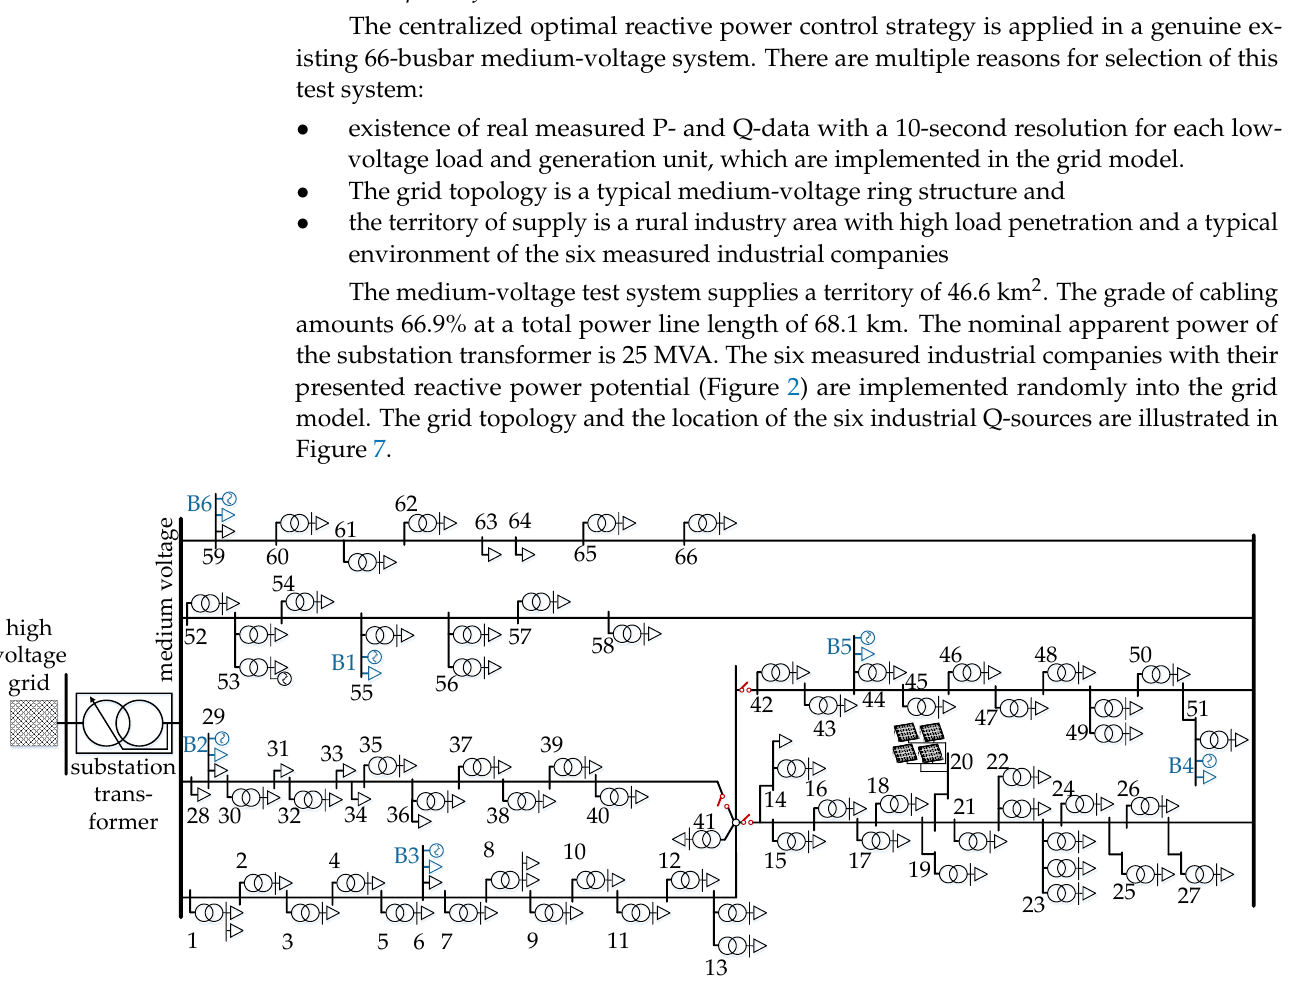
Figure 7. Schematic illustration of the radial topology of the regarded 66-busbar medium-voltage grid with separation points in open position (red) the six implemented industrial companies (blue, B1 to B6) and their reactive power potential (generation units).